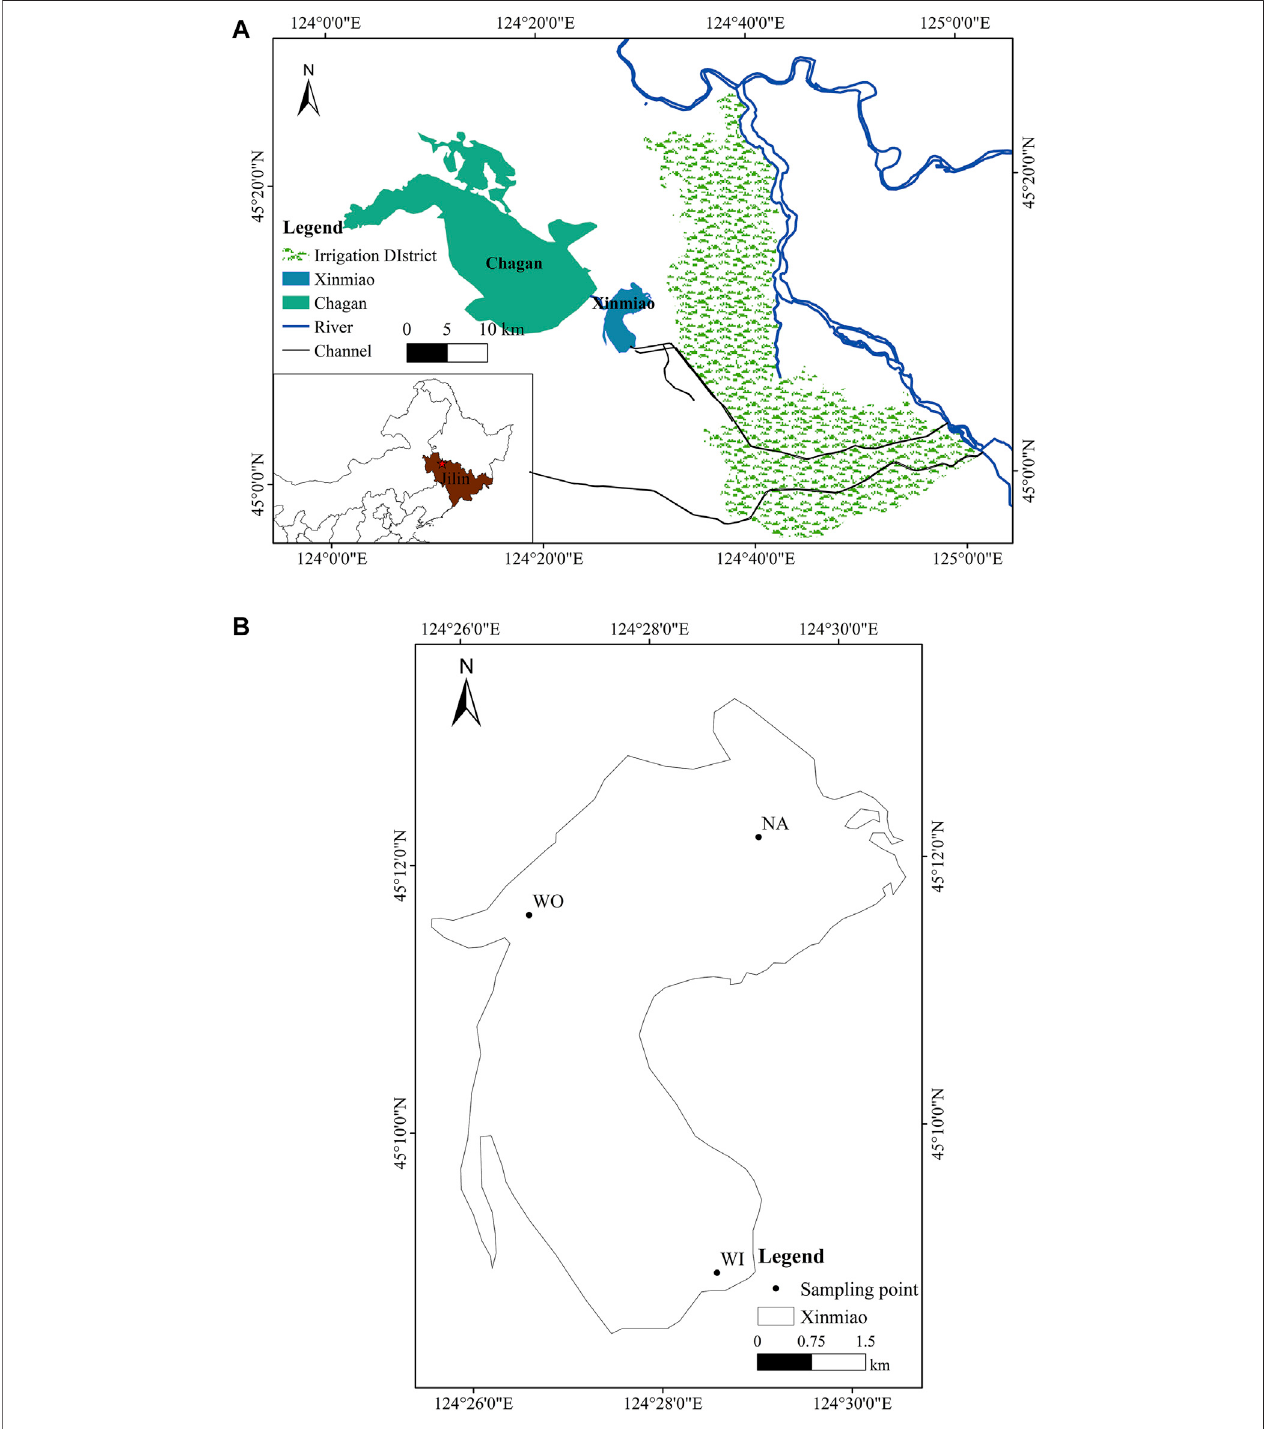
FIGURE 1 | Schematic diagram of sampling points. Panels show the geographical location of XinmiaoLake (A) and the speci fi c layout of sampling points (B) .